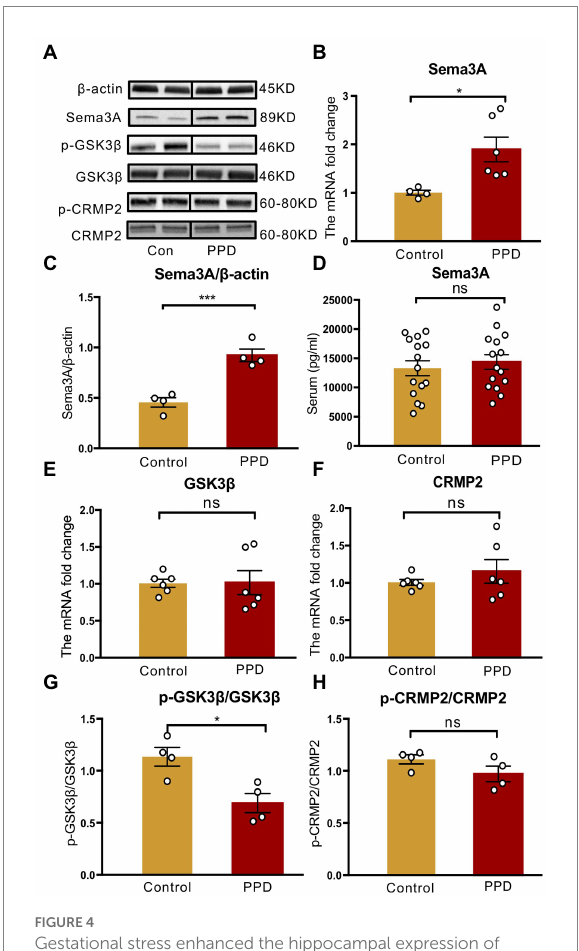
FIGURE 4 Gestational stress enhanced the hippocampal expression of Sema3A and inhibited the phosphorylation of GSK3 β . (A) Representative western blot images indicating the Sema3A, GSK3 β , p-GSK3 β , CRMP2, p-CRMP2, and β -Actin protein bands. Full-length blots are presented in Supplementary Figure 2. (B,C) The mRNA and protein expressions of Sema3A in two groups. (D) The level of serum Sema3A examined by ELISA in two groups. (E,F) The mRNA expression of GSK3 β , CRMP2 in two groups. (G,H) The relative protein expression of p-GSK3 β /GSK3 β and p-CRMP2/CRMP2 and in two groups. Data were mean ± SEM. White circles represent individual data points. * p < 0.05; *** p < 0.001 vs. Con; ns, not significant (unpaired t